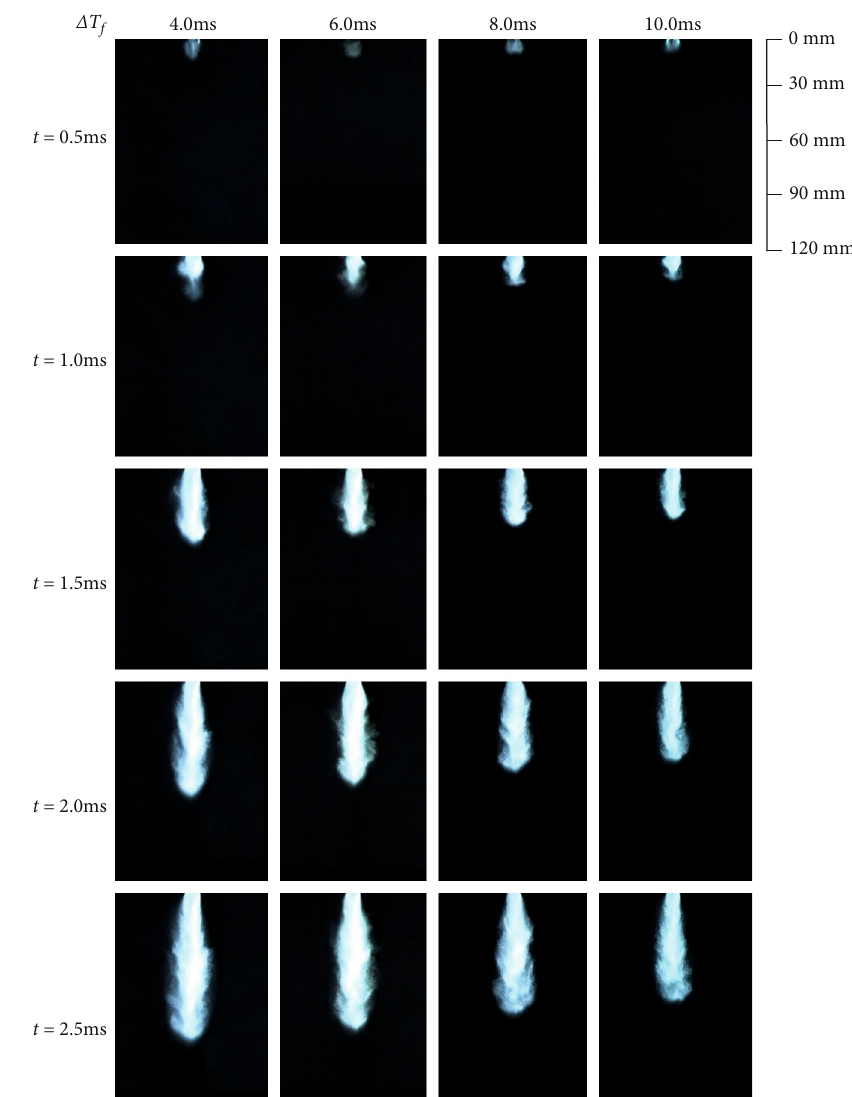
= 0 : 8 MPa , T = 298K f f